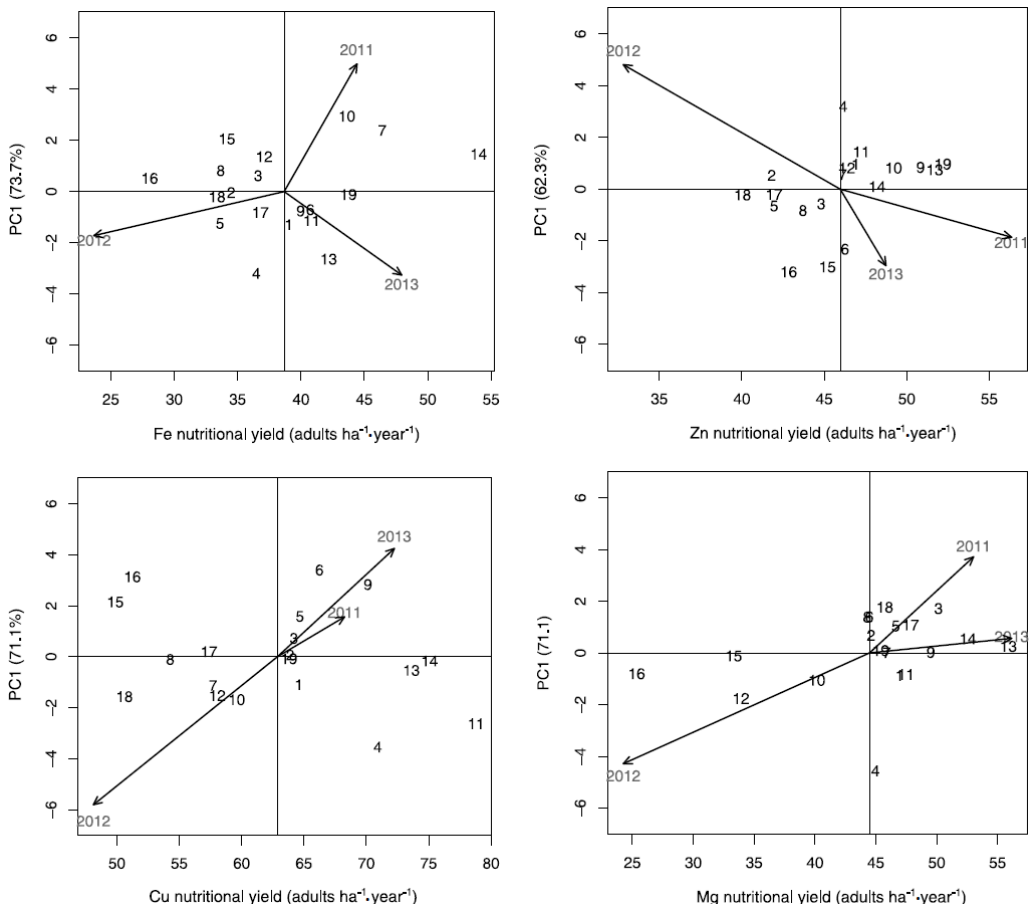
Figure 2. AMMI biplots of nutritional yield showing nutritional yield scores (adults ha − 1 · year − 1 ) for ( a ) Fe, ( b ) Zn, ( c ) Cu, and ( d ) Mg versus the first principal component (PC1) score of the 19 winter wheat genotypes and the three years of production in the locality of Ekhaga. The first principal components (PC1) explain 73.7%, 62.3%, 71.1%, and 71.1% of the genotype by year interaction variance of Fe, Zn, Cu, and Mg nutritional yield, respectively. Genotypes are represented by the ID numbers from Table 1. Years of production are designated by the year of harvest. The vertical axis indicates the overall average nutritional yield (adults · ha − 1 · year − 1 ) across the three years of production. Genotypes closer to the horizontal axis (score 0 on PC1) had a relatively more stable nutritional yield across the three